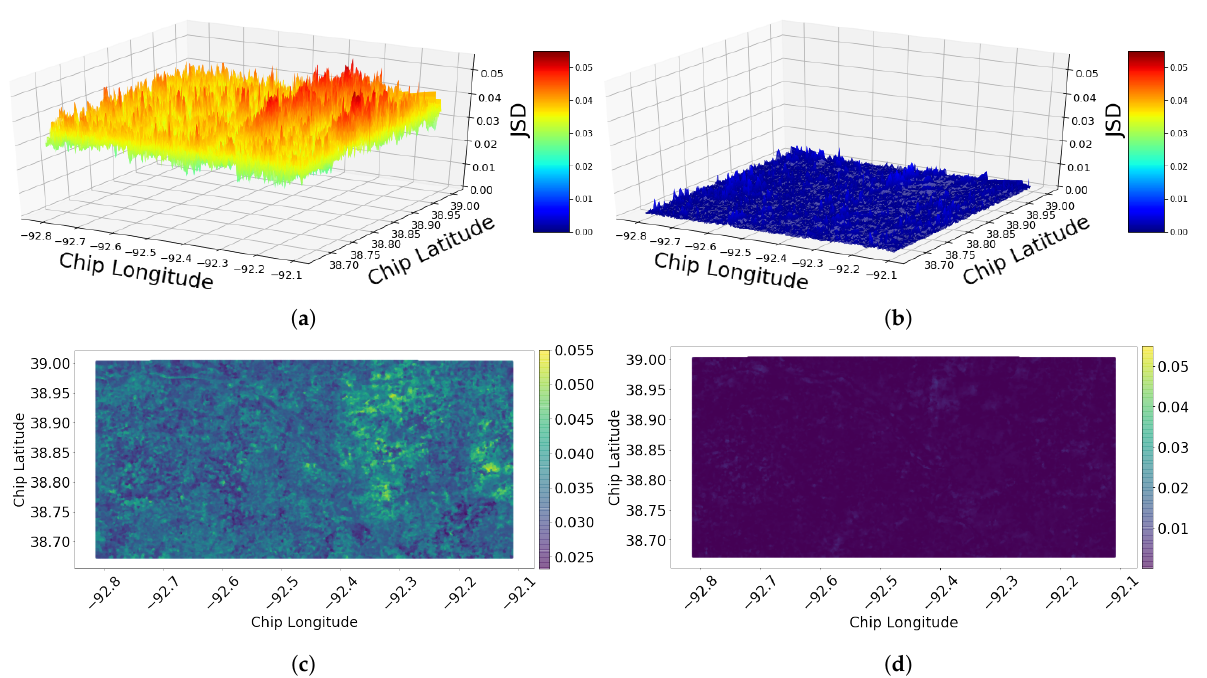
Figure 11. Jensen–Shannon divergence (JSD) of the change based on the chip-level utilizing neighborhood method of (M-N) during two different time periods: ( a ) 3D (2011–2015). ( b ) 3D (2015–2017). ( c ) 2D (2011–2015). ( d ) 2D (2015–2017). Figure 12 illustrates the change detection in a sampled set of chips for the time window 2015–2017 utilizing the 1–N neighborhood method. The new construction (removal of trees along with the addition of road and houses) represents ground-truth visual change that measures higher than the surrounding areas, which are less impacted by the change activities.